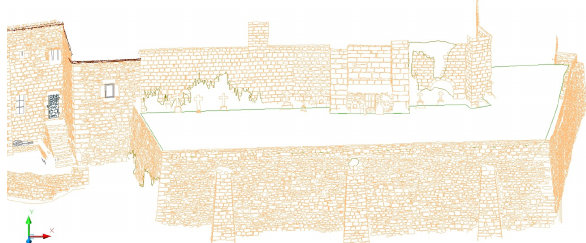
Figure 11. Photograph that is part of an oblique stereopair of one of the towers of the wall of Labraza.